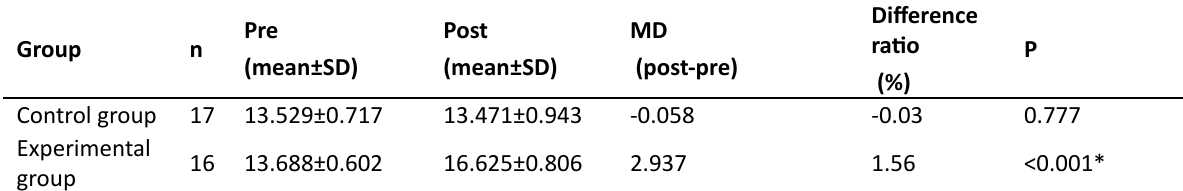
Table 3. FMS total score changes within groups